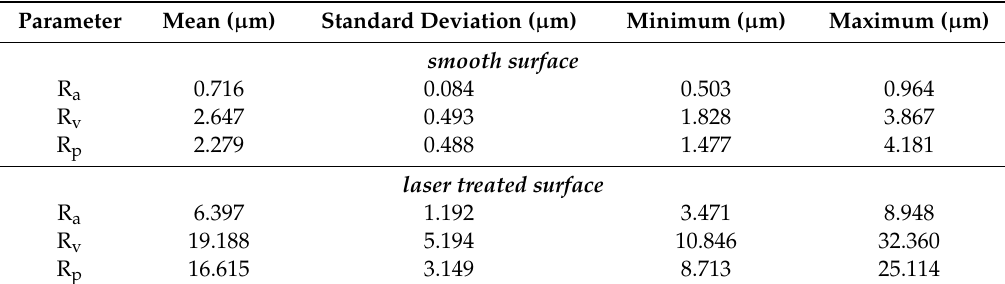
Table 2. Details of the surface roughness.